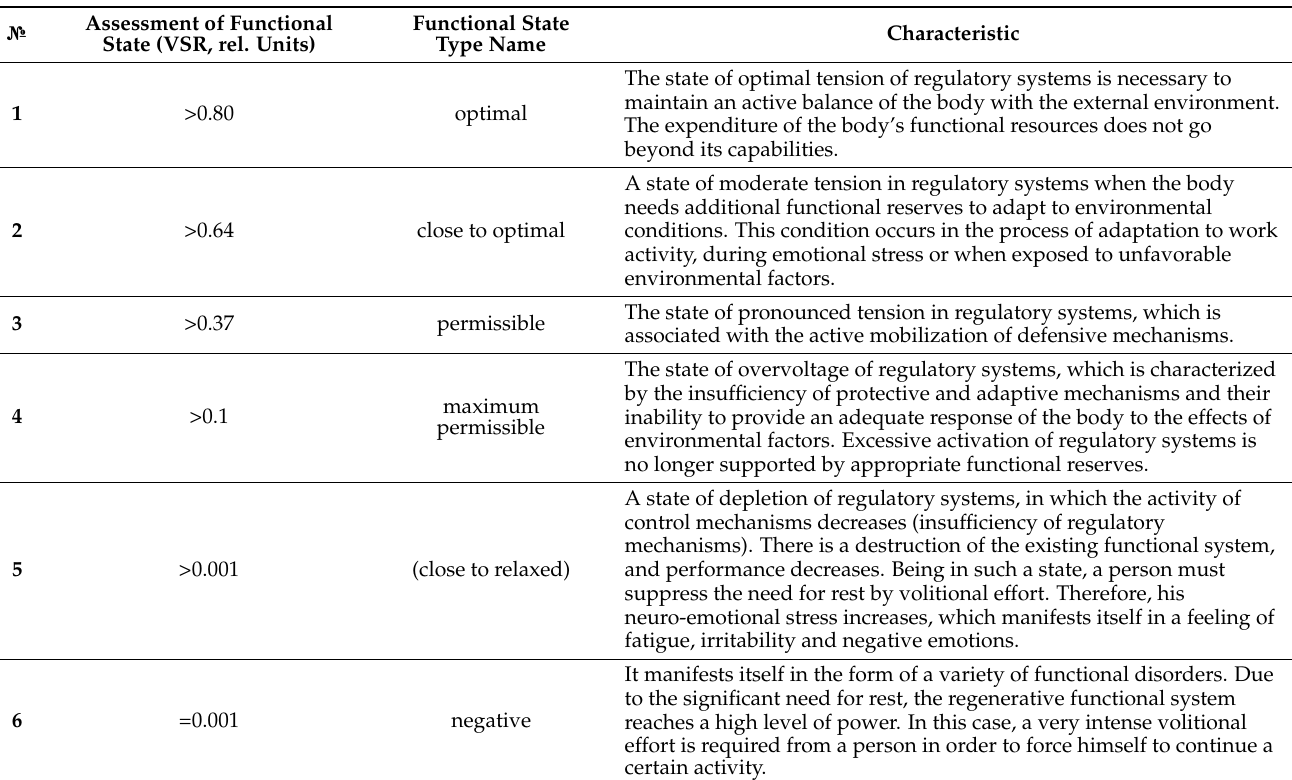
Table 2. Types of general functional state and its characteristics. Adapted with permission from Ref. [58] NPKF “Medicom MTD”,